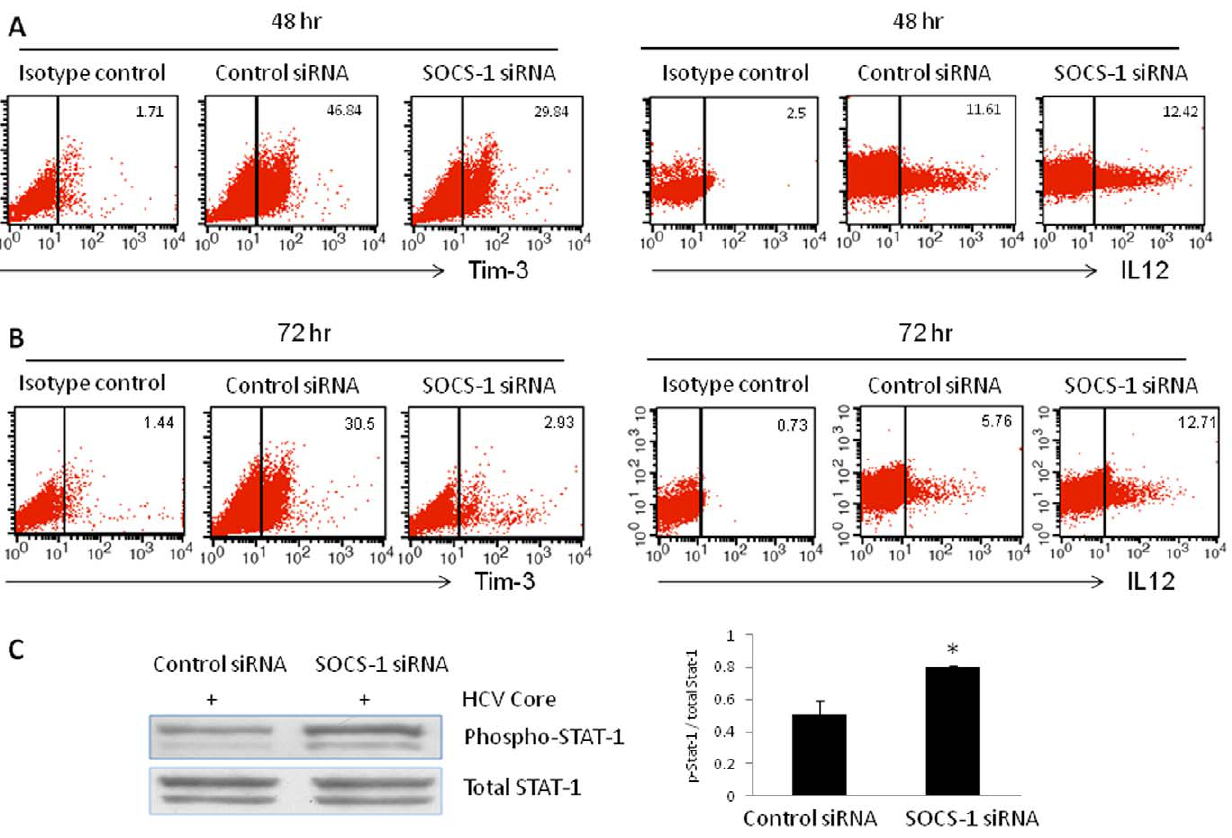
Figure 8. SOCS-1 silencing regulates HCV core-mediated Tim-3 expression, IL-12 production, and STAT-1 phosphorylation in THP-1 Cells. A) and B) THP-1 cells were transfected with SOCS-1 siRNA or control siRNA, followed by HCV core and LPS/R848 stimulation for another 48 and 72 h, then subjected for the expression of Tim-3 and IL-12 analysis by flow cytometry. C) The same cells were also subject to Western blot for detection of STAT-1 phosphorylation. The figures show one representative blot and summary densitometry data of 3 repeated experiments.